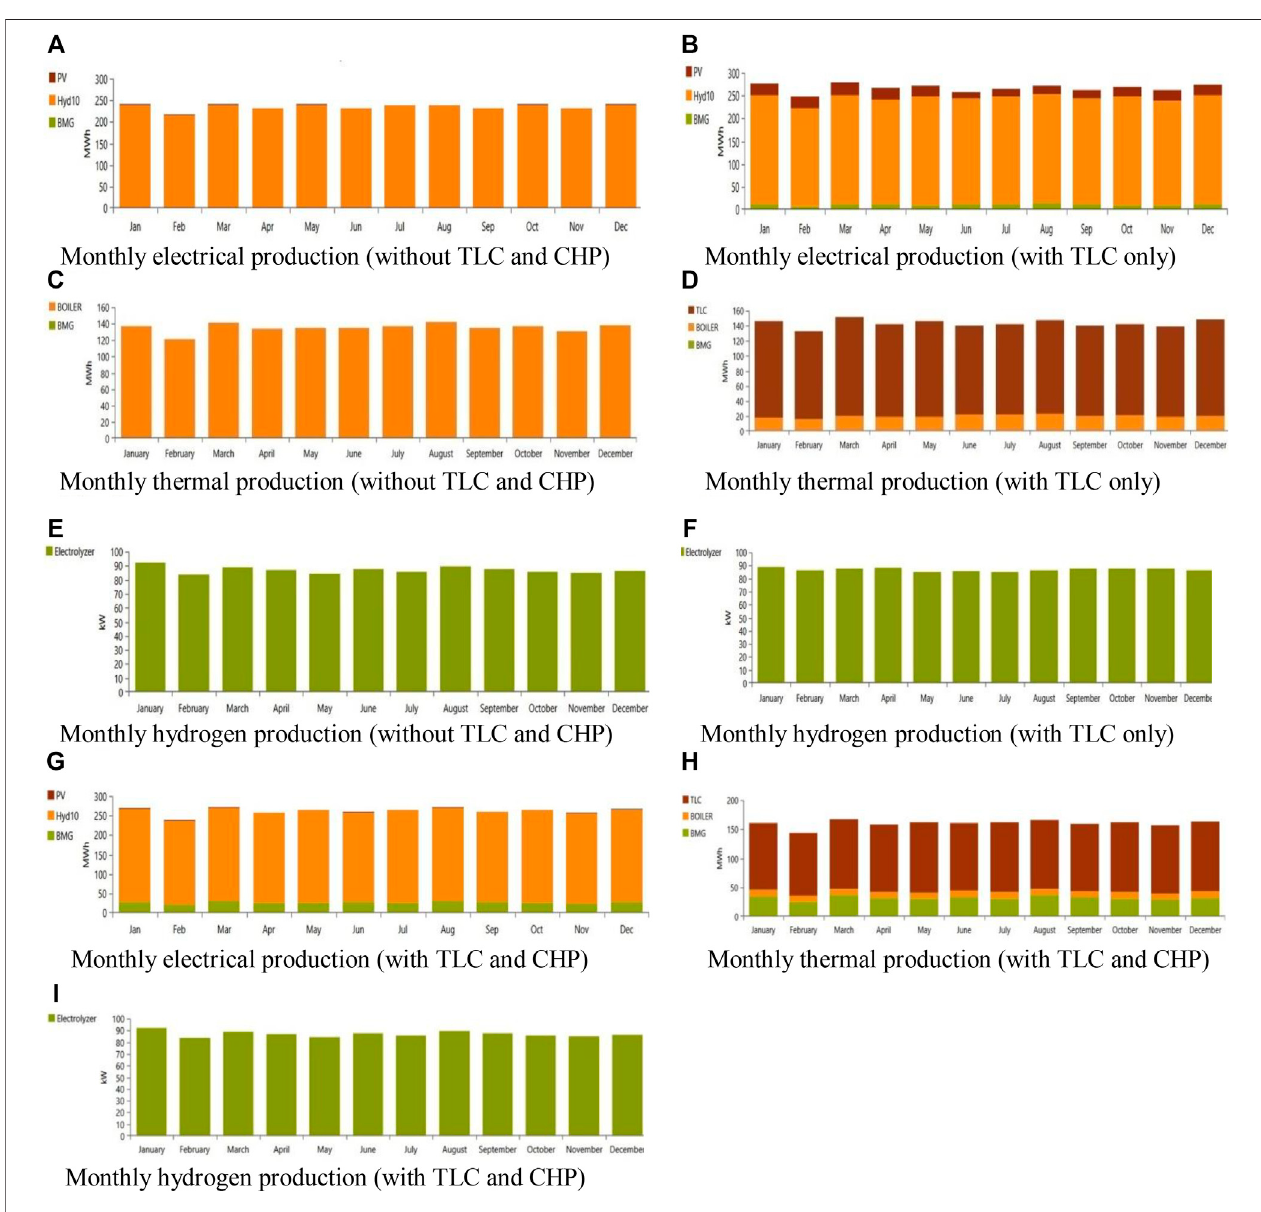
FIGURE 10 | Monthly energy productions. (A) Monthly electricalproduction (withoutTLCand CHP). (B) Monthly electricalproduction (with TLConly). (C) Monthly thermal production (without TLC and CHP). (D) Monthly thermal production (with TLC only). (E) Monthly hydrogen production (without TLC and CHP). (F) Monthly hydrogen production (withTLConly). (G) Monthlyelectricalproduction(withTLCandCHP). (H) Monthlythermalproduction(withTLCandCHP). (I) Monthlyhydrogenproduction(withTLCandCHP).